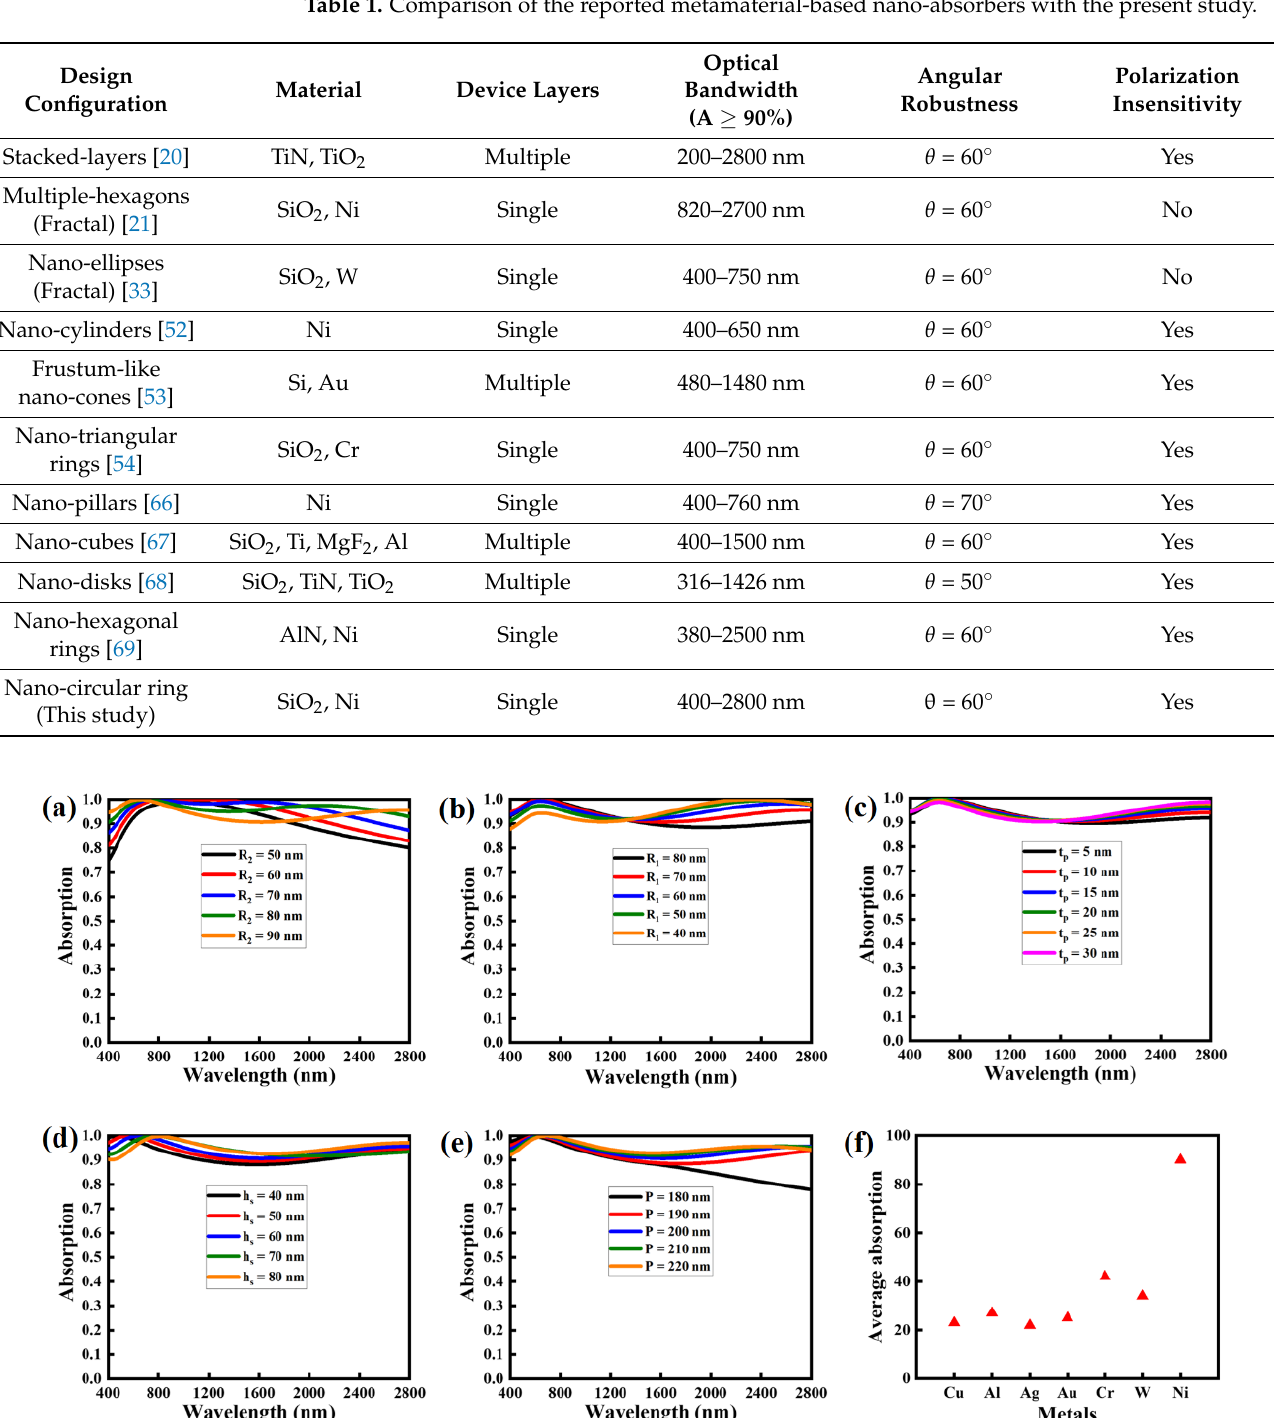
Table 1. Comparison of the reported metamaterial-based nano-absorbers with the present study.